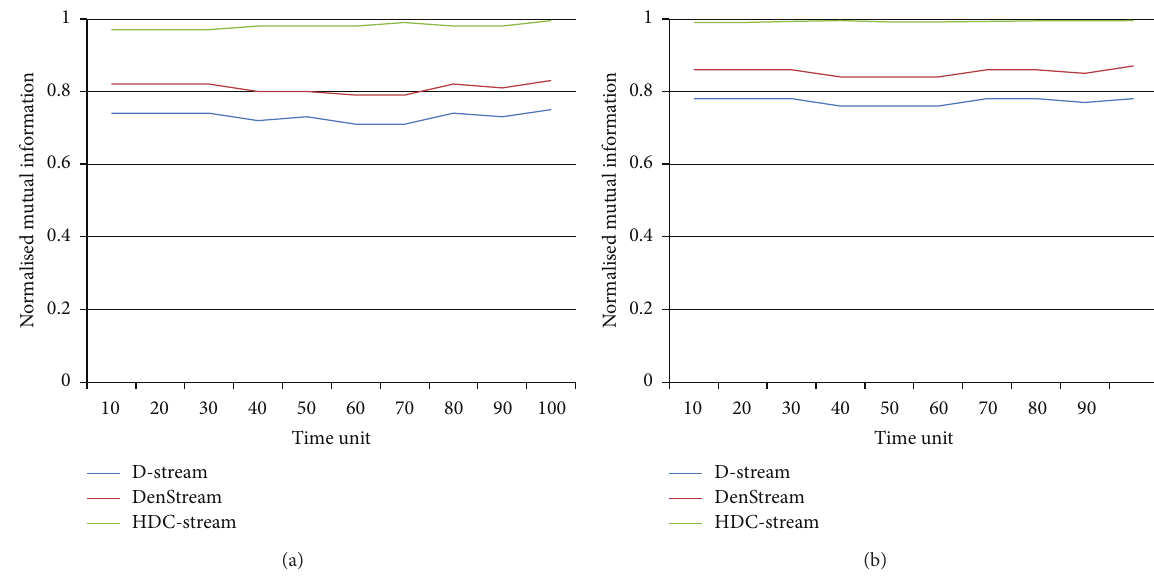
Figure 6: Normalised mutual information of HDC-Stream for EDS with (a) horizon = 1 and stream speed = 2000 and (b) horizon = 5 and stream speed = 2000.